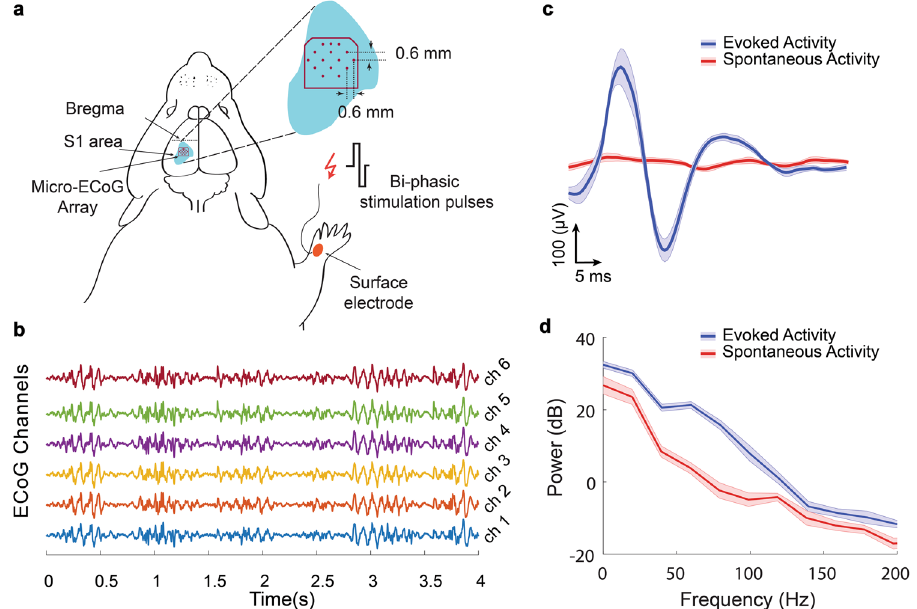
Figure 8. ( a ) Schematic figure showing implantation site of GC microelectrodes array on the left forelimb sensory cortex. Electrical stimulation was applied on the skin of the right wrist. ( b ) Example of raw ECoG data recorded using GC microelectrode arrays implanted on the forelimb area of rat sensory cortex. ( c ) Average-SEP response related 5–55 ms after surface electrical stimulation of hand skin with the average-spontaneous activity related to 65–115 ms after stimulation ( d ) the power spectrum (mean ± standard error) for sensory evoked response and spontaneous activities corresponding to the same signals shown in Fig. 8c.